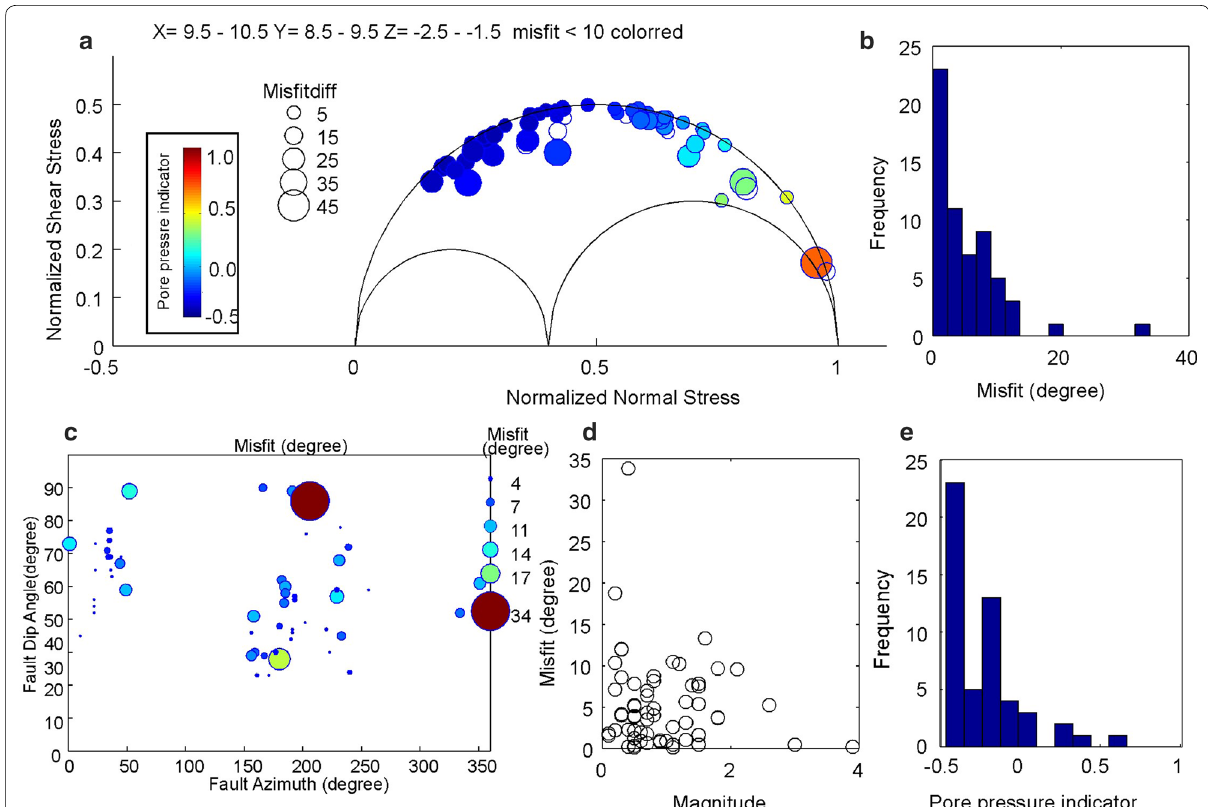
Fig. 10 a Plots of the normalized shear and normal stresses on faults on a three‑dimensional Mohr diagram for a grid point ( x Pore pressure indicators P p are calculated as P p fault plane and auxiliary plane (misfitdiff); coloring indicates only data with misfits on the fault plane greater than the error of focal mechanisms, 10°. b Histogram of misfits. c Relationship between azimuths and dip angles of the fault planes. Misfits are also indicated by the sizes and colors of circles. d Relationship between magnitude and misfit. e Histogram of the pore pressure indicator, P